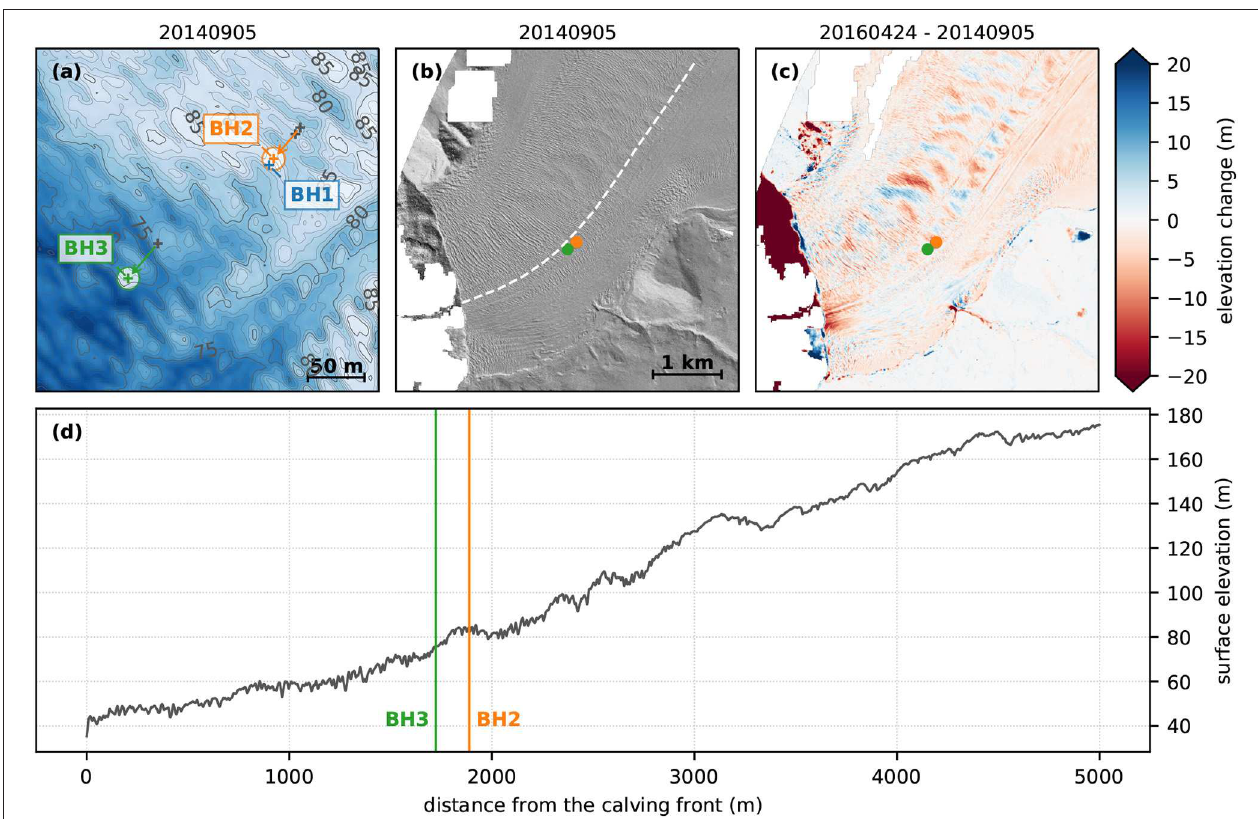
FIGURE 5 | (a) Glacier surface topography in the vicinity of the boreholes sites in the early phase of the experiment (Arctic DEM, 2014 Sep. 5) and corresponding locations of the boreholes. The locations of BH2 and BH3 are estimated from their initial locations in July 2014 (color crosses) and the displacement of BH1 measured by continuous GPS during the corresponding time intervals. (b) Multiple illumination shaded relief map of the terminal tongue of Bowdoin Glacier from the same data. (c) Elevation change between 2014 Sep. 5 and 2016 Apr. 24 (Arctic DEM) showing generalized thinning, local thinning near the calving front, and the advection of glacier surface undulations. (d) Glacier surface topographic profile along a flow line passing near BH1 and the estimated location of